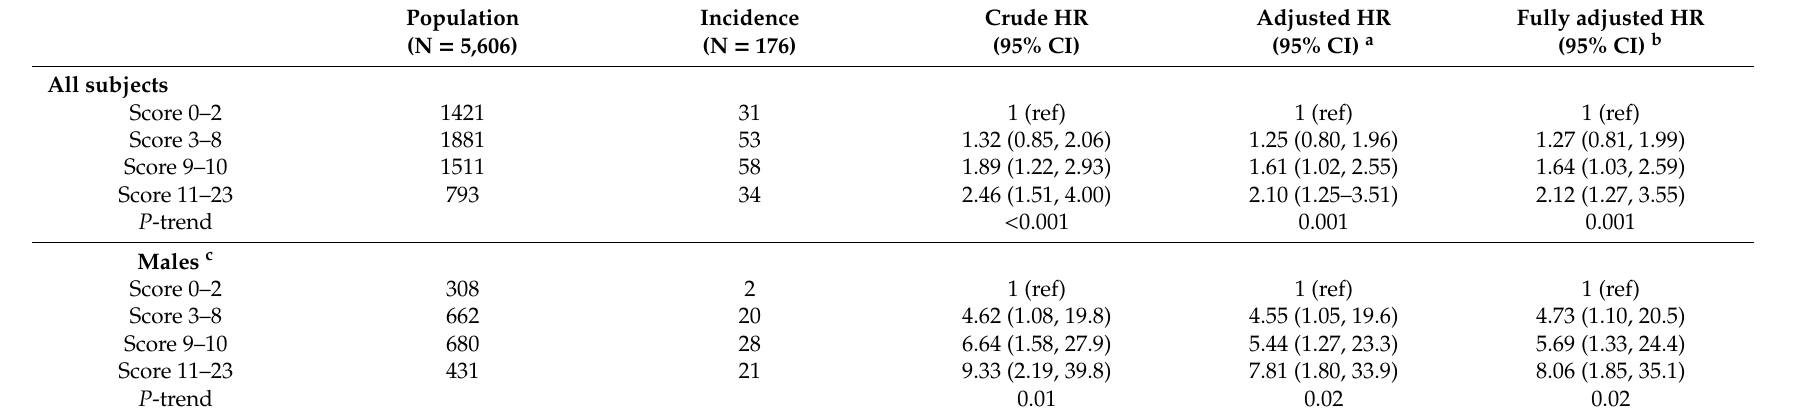
Table A4. Comorbidity scores and the risk of cancer incidence after removing total cholesterol from comorbidity risk